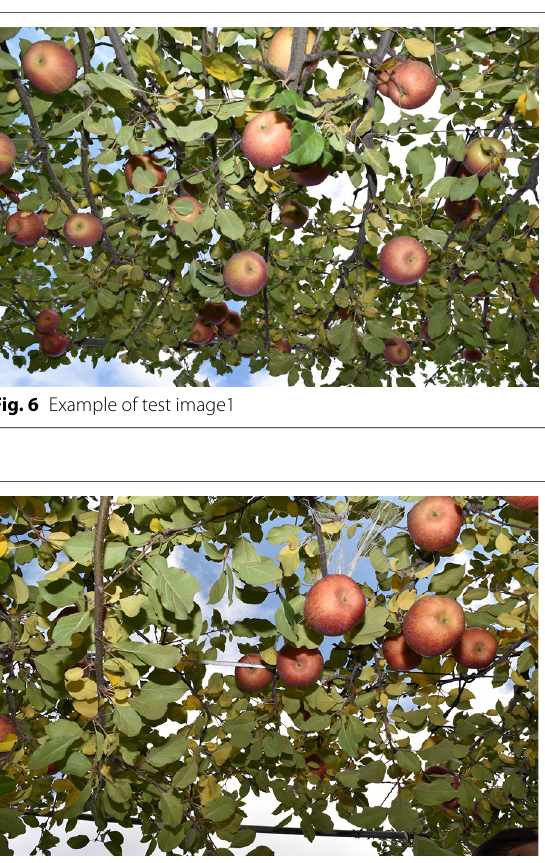
Fig. 7 Example of test image2